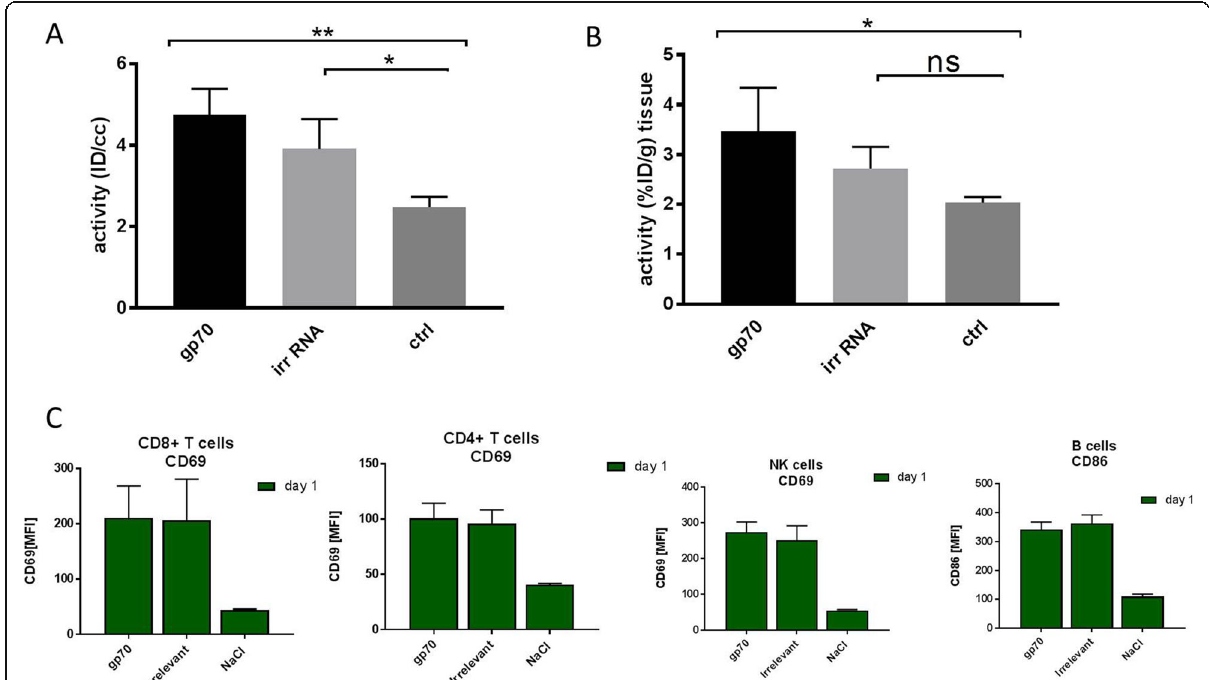
Fig. 4 Comparison of FDG uptake in spleen 24 h after two vaccination cycles of gp70 encoding RNA-lipoplexes and irrelevant RNA-lipoplexes not encoding protein information ( a in vivo PET; b ex vivo biodistribution). c Increased levels of activation markers CD69 and CD86 were observed in lymphocyte populations and NK cells with RNA irrespective of content 24 h after the second vaccination